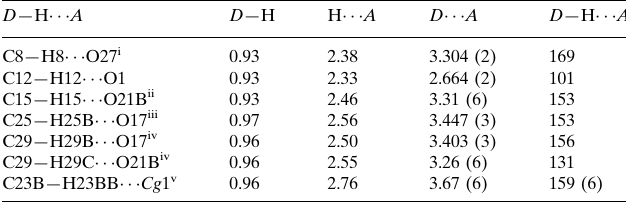
Hydrogen-bond geometry (A˚ , (cid:2)